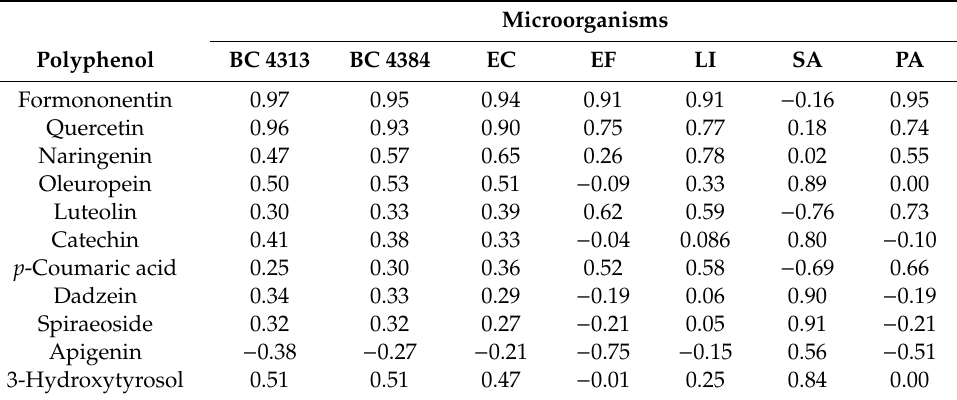
Table 5. Correlation coe ffi cients between the potential antibacterial activity and polyphenols identified in the extracts of ‘Ogliarola’, ‘Ravece’ and ‘Ruvea antica’ EVOOs, with respect to di ff erent pathogens. The analysis was elaborated with respect to the percentage of each molecule present in the extracts, taking into account the amounts (2.5 µ g and 4.9 µ g) of the extracts used to determine the antibacterial activity of the extracts against di ff erent pathogens. BC: Bacillus cereus (strains DSM 4313 and DSM 4384); EC: Escherichia coli ; LI: EF: Enterococcus faecalis ; Listeria innocua ; SA: Staphylococcus aureus; PA: Pseudomonas aeruginosa .